Question: Express in one sentence what the figure is showing.
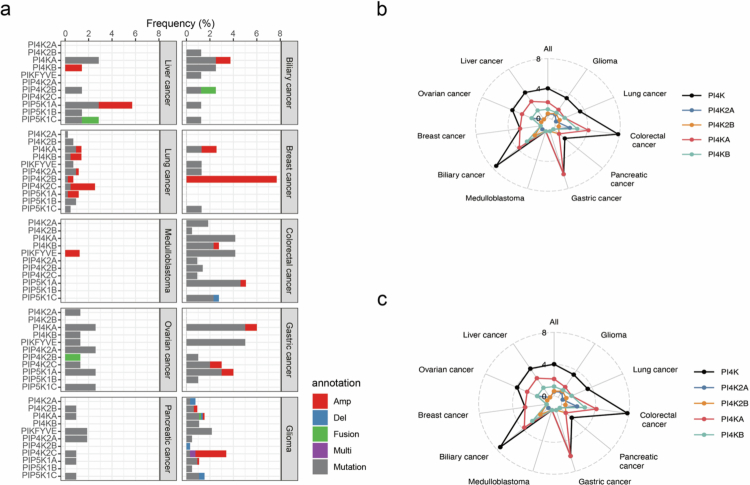
Answer: The alteration landscape of PI4K and PIPK family genes across different cancer types. a, Mutation types of individual PI4K and PIPK family genes in various cancers. The bar plot shows the frequency of alterations, categorized as Amplification (Amp), Deletion (Del), Fusion, Multi-mutation (Multi), or Mutation. b-c, Alteration frequencies of PI4K (b) and PIPK (c) family genes across cancer types.